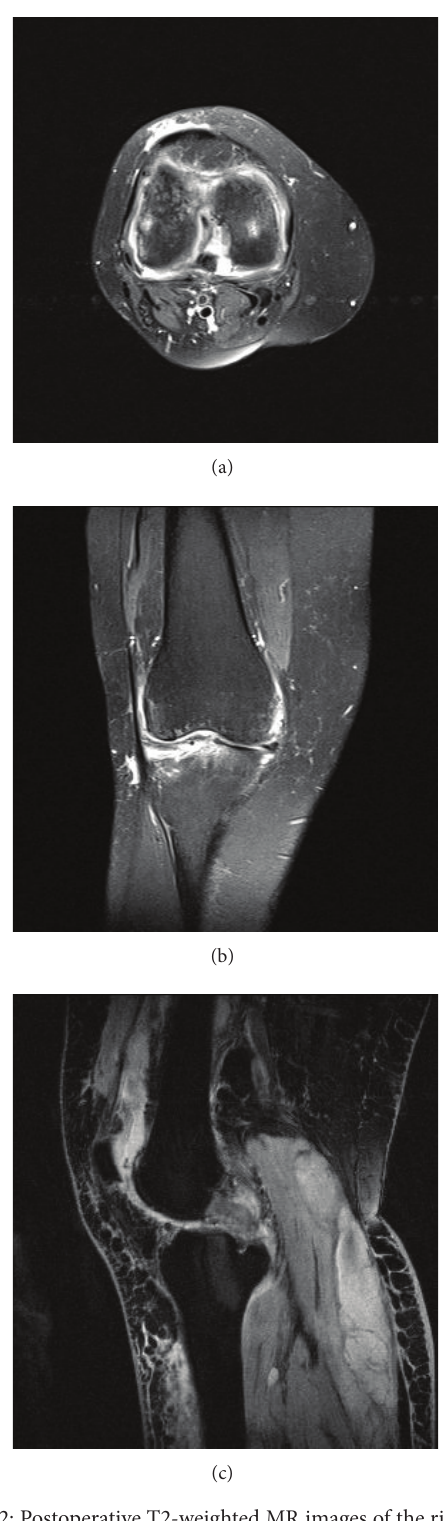
Figure 2: Postoperative T2-weighted MR images of the right knee, revealing effusion in the knee joint and popliteal fluid collection.